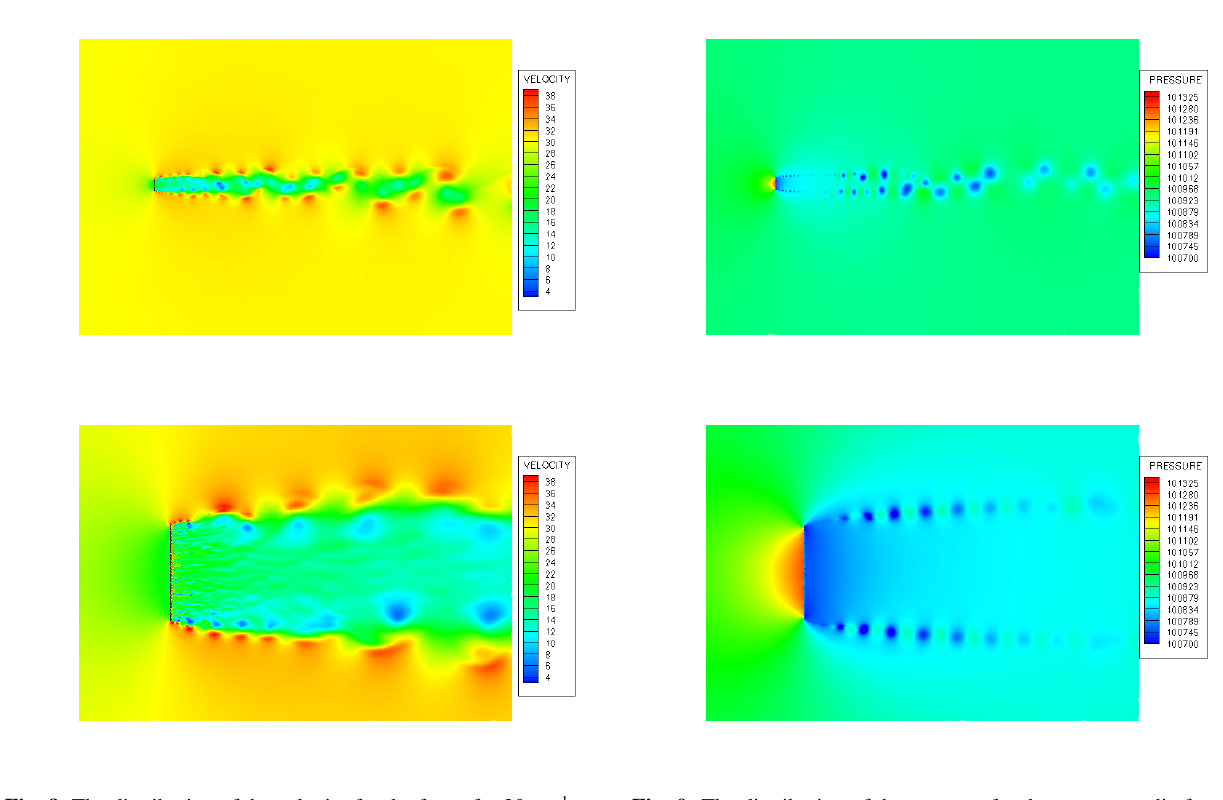
Fig. 8. The distribution of the velocity for the fence for 30 ms − 1 . Fig. 9. The distribution of the pressure for the porous media for 30 ms − 1 .